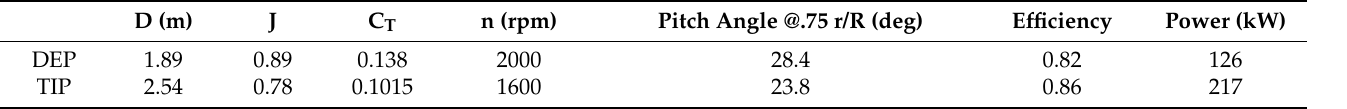
Table 8. Propellers take-off operating points. Both DEP and TIP propellers have a right-handed